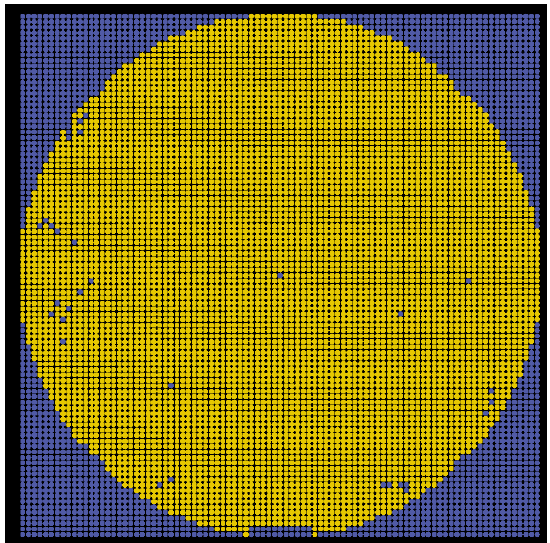
Figure 9. Initial wafer mapping result from detected and predicted die